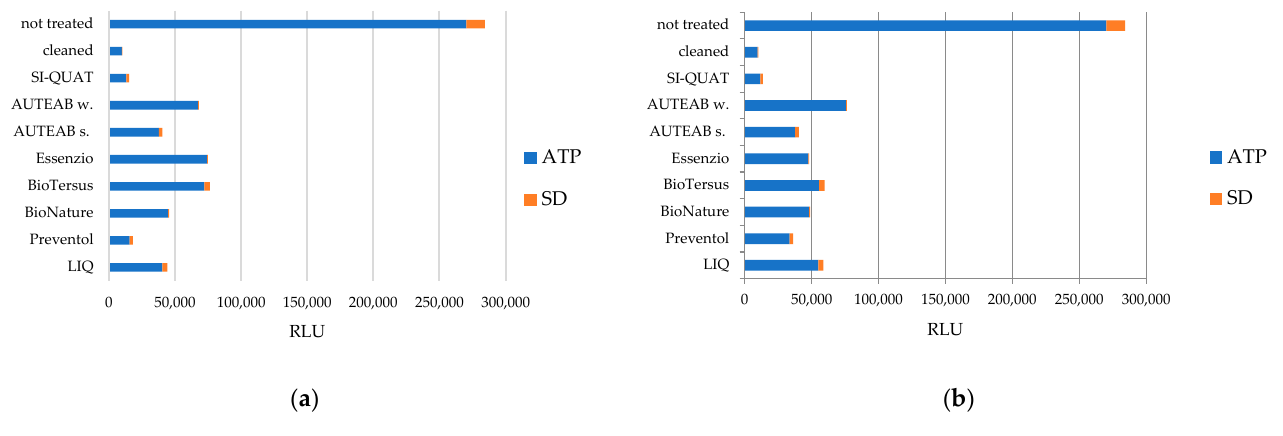
Figure 5. Histograms reporting the measures of ATP (in blue) collected after the treatment of each tested zone of Area 1 ( a ) and Area 2 ( b ) and a non-treated zone ( a , b ). 3.4. Analysis for the Evaluation of Products’ Long-Lasting Trend The long-lasting trend of the biocides was examined after seven months (Figure 6). At macroscopic observation, slightly visible green biological growth was observed on the areas. On Area 1, z4, z6_1, and z2, where Preventol ® RI50, SI-QUAT, and AUTEAB were, respectively, applied, appeared to be less contaminated. On z4, z8, and z2 of Area 2, where SI-QUAT, Biotersus and Preventol ® RI50 were tested, no visible re-growth was observed. The greatest performance was obtained on z4 of both Area 1 and Area 2, where the product SI-QUAT was applied, confirming its preservation ability.